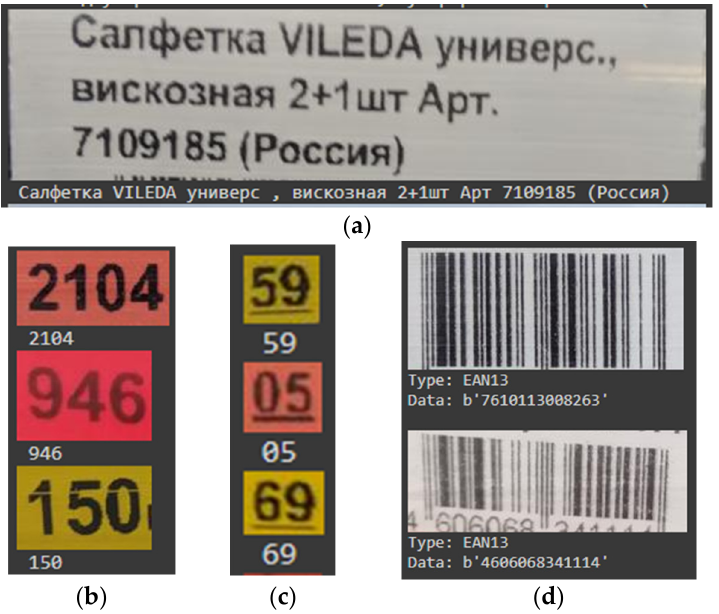
Figure 11. ( a ) Median filter with core = 1; ( b ) median filter with core = 3; ( c ) median filter with core = 5.